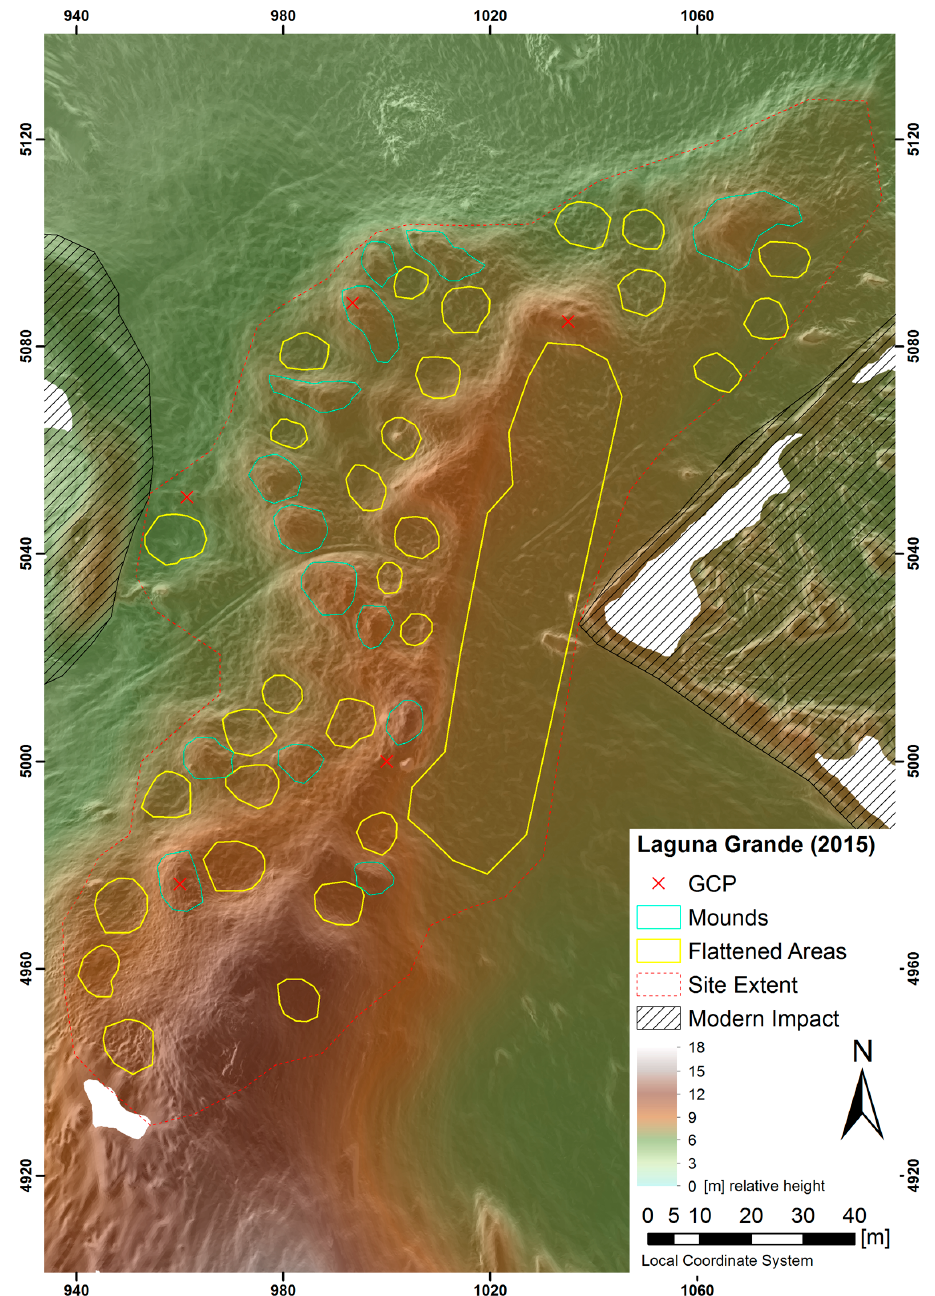
Figure 7 . DEM overlaying a hillshade model, and interpretation of mounds and flattened areas of the settlement site of Laguna Grande .